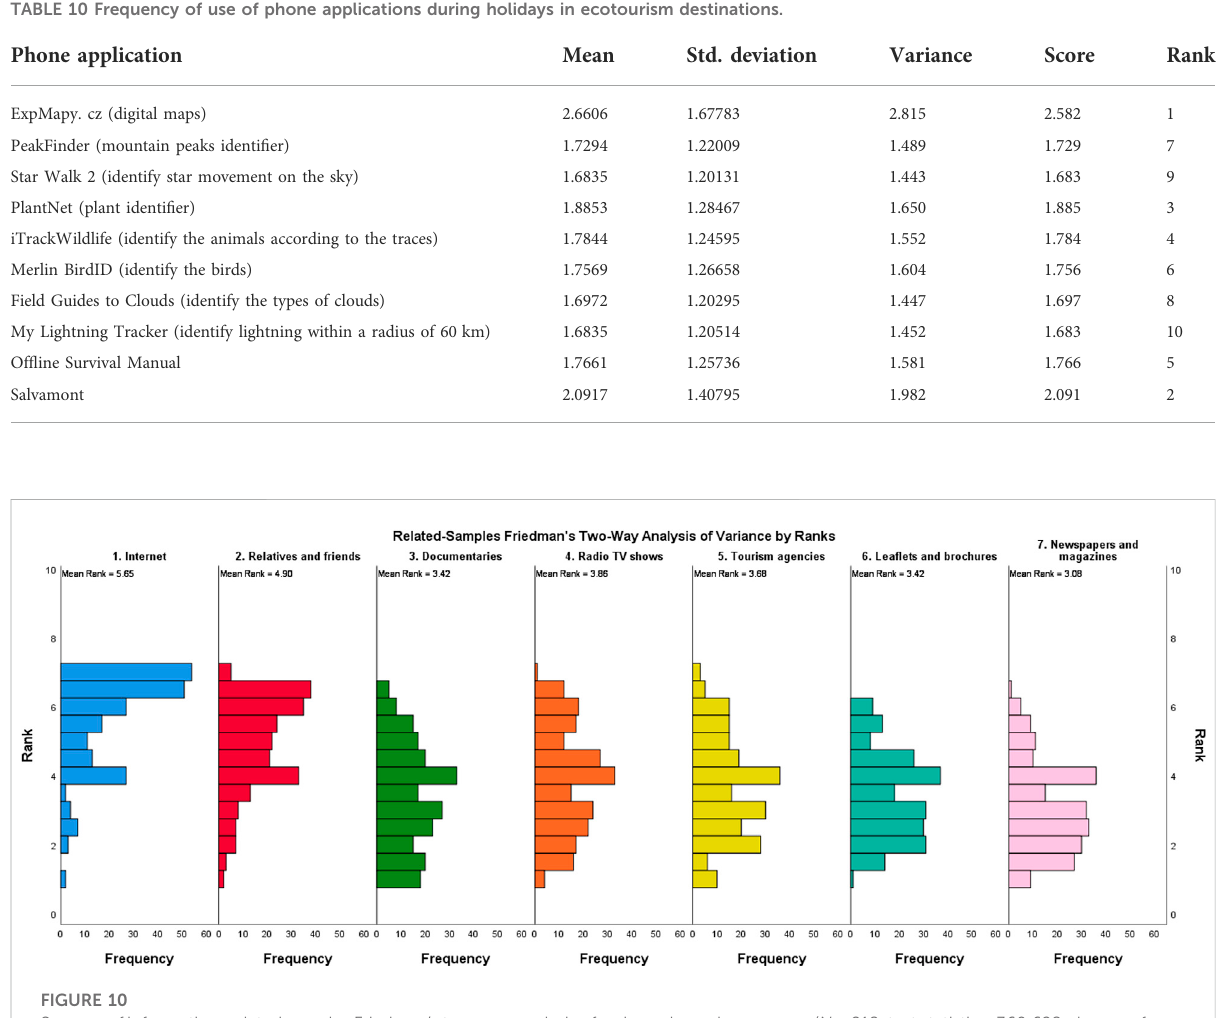
TABLE 10 Frequency of use of phone applications during holidays in ecotourism destinations.